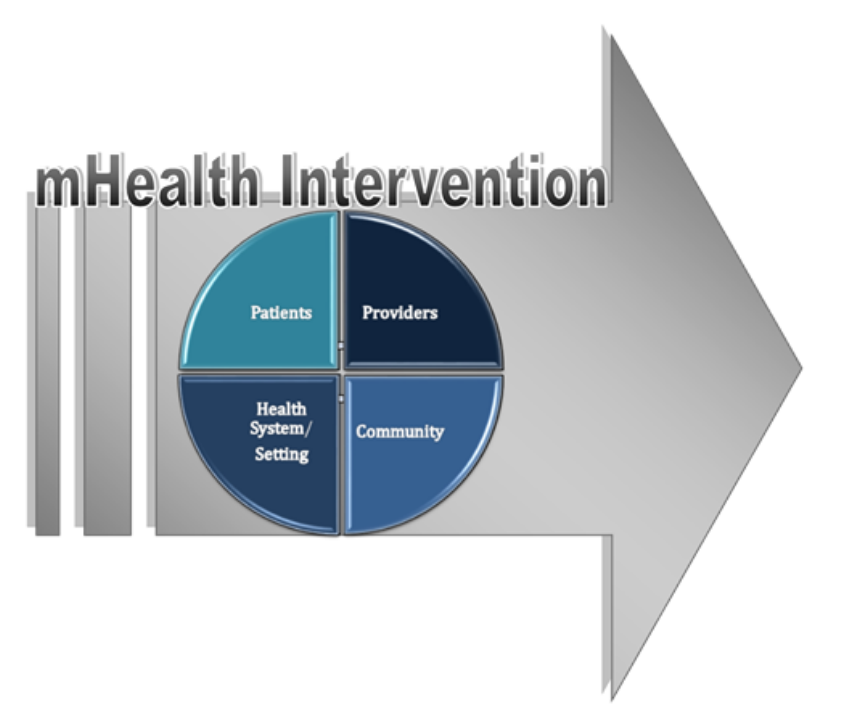
Figure 2. Major factors that interact with the DREAM-GLOBAL mHealth